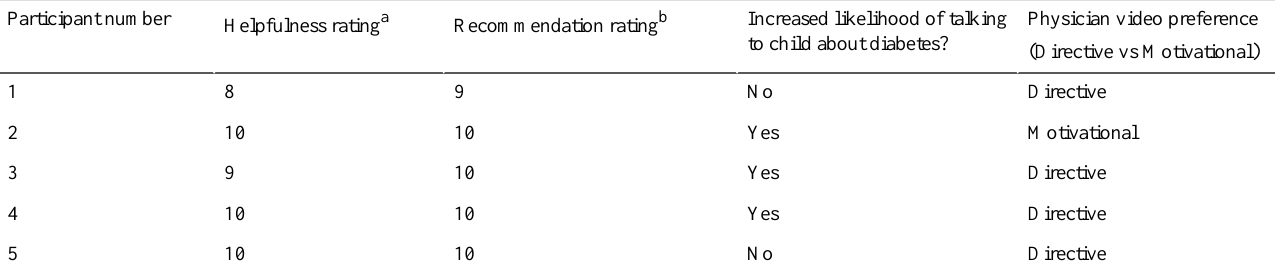
Table 2. Caregiver ratings of The 3 Ms